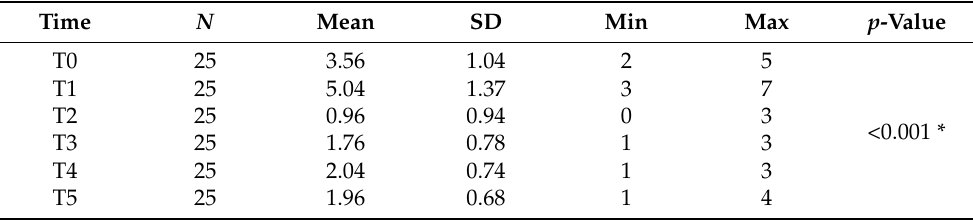
Figure 5. Mean VAS scores between two groups at different time intervals. A comparison of the mean VAS scores between various time intervals using Freidman’s test also gave a statistically significant result at p < 0.001 between different time frames. (Table 2). Table 2. Comparison of mean VAS scores between time intervals in the test group using Friedman’s test.